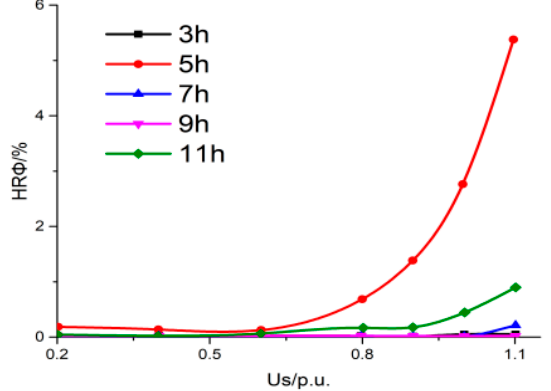
Figure 14. Variation trend of phase flux harmonic content.